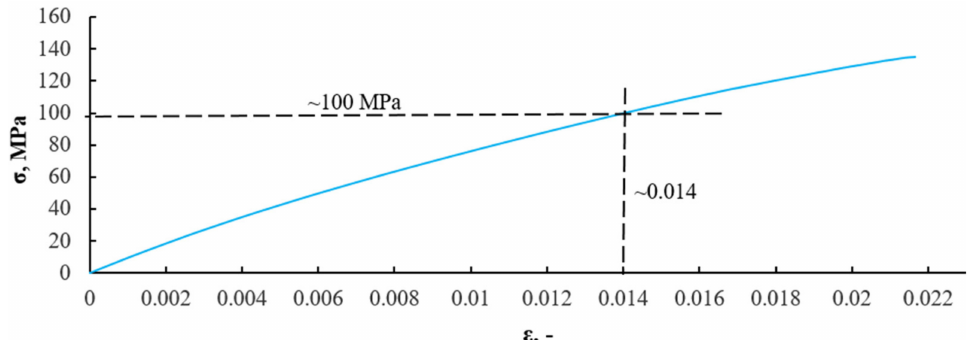
Figure 10. Determination of stress value on a composite without recyclate sample corresponding to strain ε = 0.014 (90 s of time in Figure